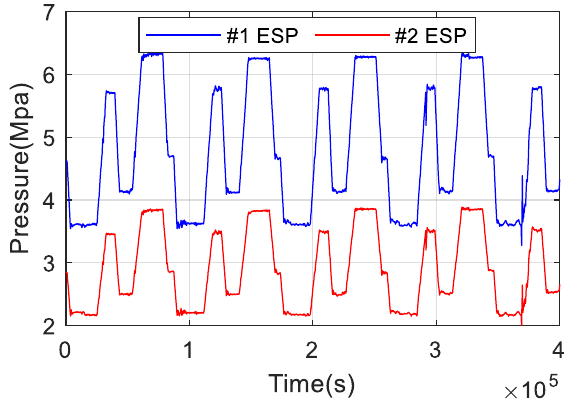
Figure 8. The pressure duration curve.